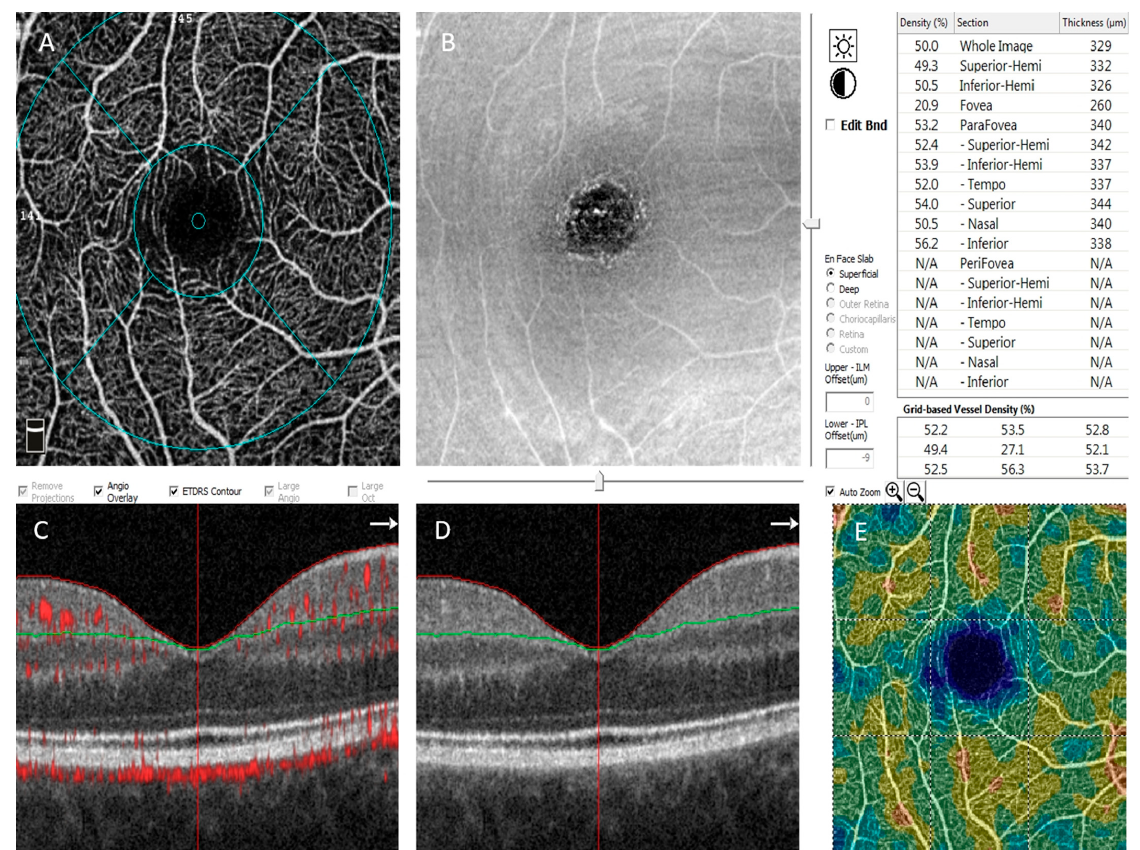
Figure 1. Representative OCTA results of a patient with diabetes ( A ) superficial retinal plexus, ( B ) en-face OCT image, ( C , D ) OCT B-scan, ( E ) superficial vessel density map and vessel density results (%) above.